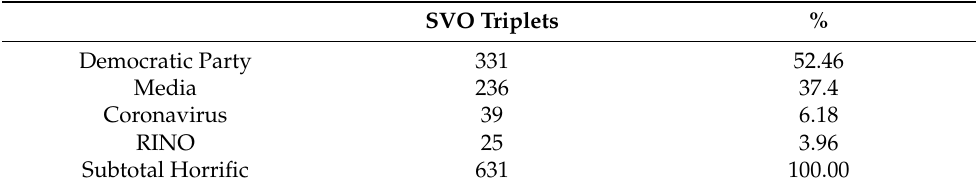
Table 3. Horrific dimension of fantasy in Trump’s Twitter discourse.